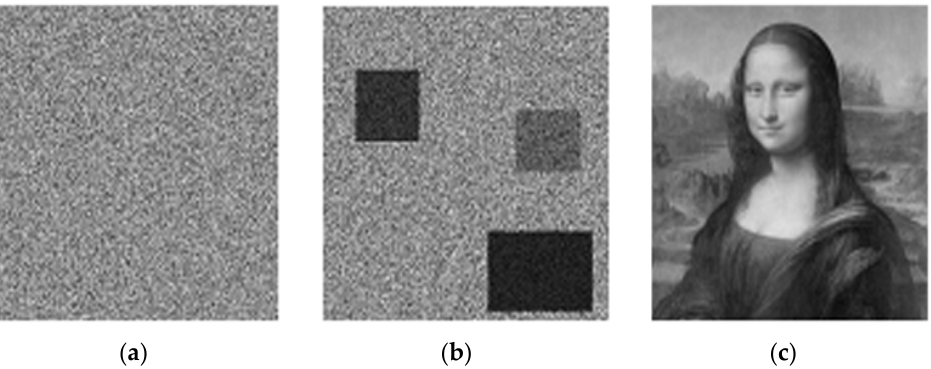
Figure 5. Benchmark image analysis; ( a ) white noise; ( b ) image with clustering; ( c ) art painting. Source: [35].